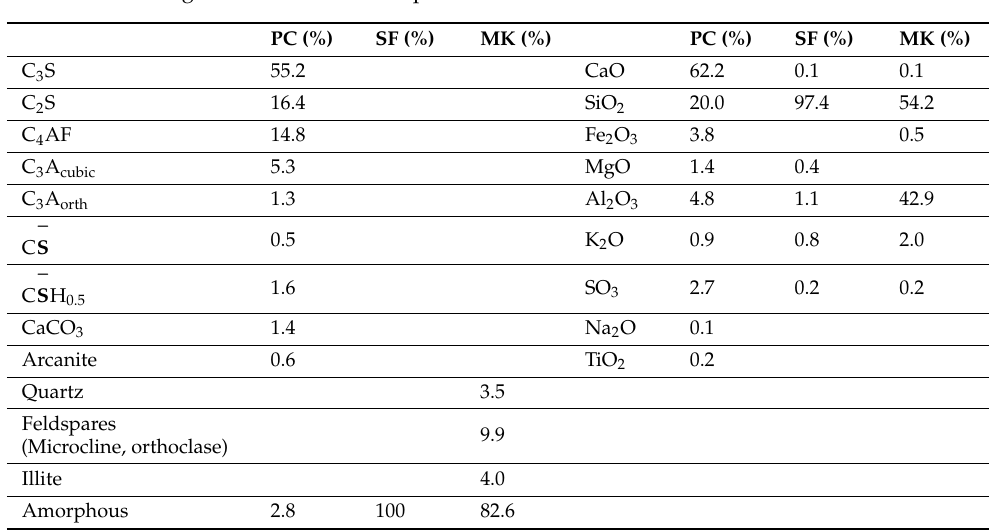
Table 2. Mineralogical and chemical composition of the materials used.